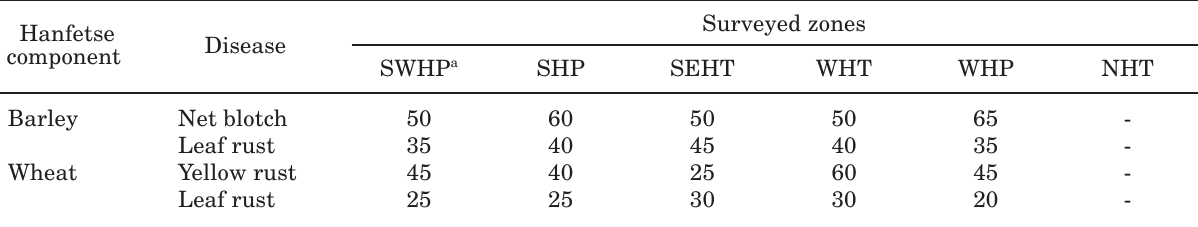
Table 4. Average incidence (%) of some diseases (net bloch, leaf rust, barley yellow rust and wheat leaf rust) on hanfetse (barley+wheat) fields in Eritrea in 2001.